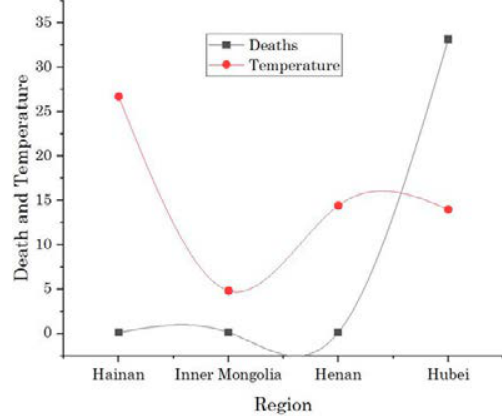
Fig. 2. Cluster results on the effect of Temperature on death cases by COVID-19